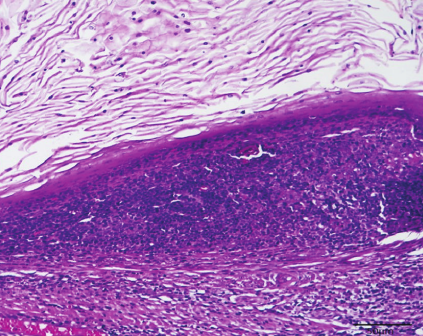
Figure 2: Histological section stained with hematoxylin-eosin, showing a stratified squamous epithelium predominantly paraker- atinized, flat interface with the conjunctive tissue, showing a dense lymphocytic infiltrate (HE × 100).